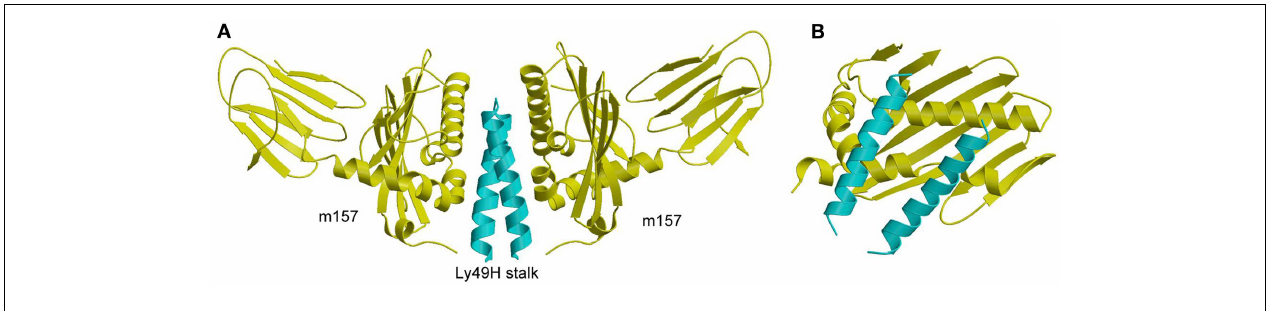
density.The rest of the Ly49H stalk (segments α 1s and α 2s) and the NKD were not resolved in the structure. (B) Top view of the Ly49H–m157 complex, in which the helical stalks of Ly49H lie across the α 1/ α 2 platform of m157.